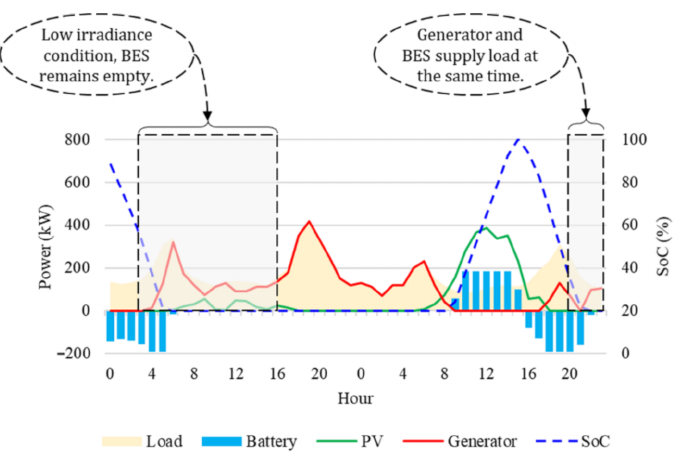
Figure 5. Analysis of LF control strategy implementation was captured on 1 and 2 January. The BES was in minimum SOC for a longer period and ran simultaneously with the generator.